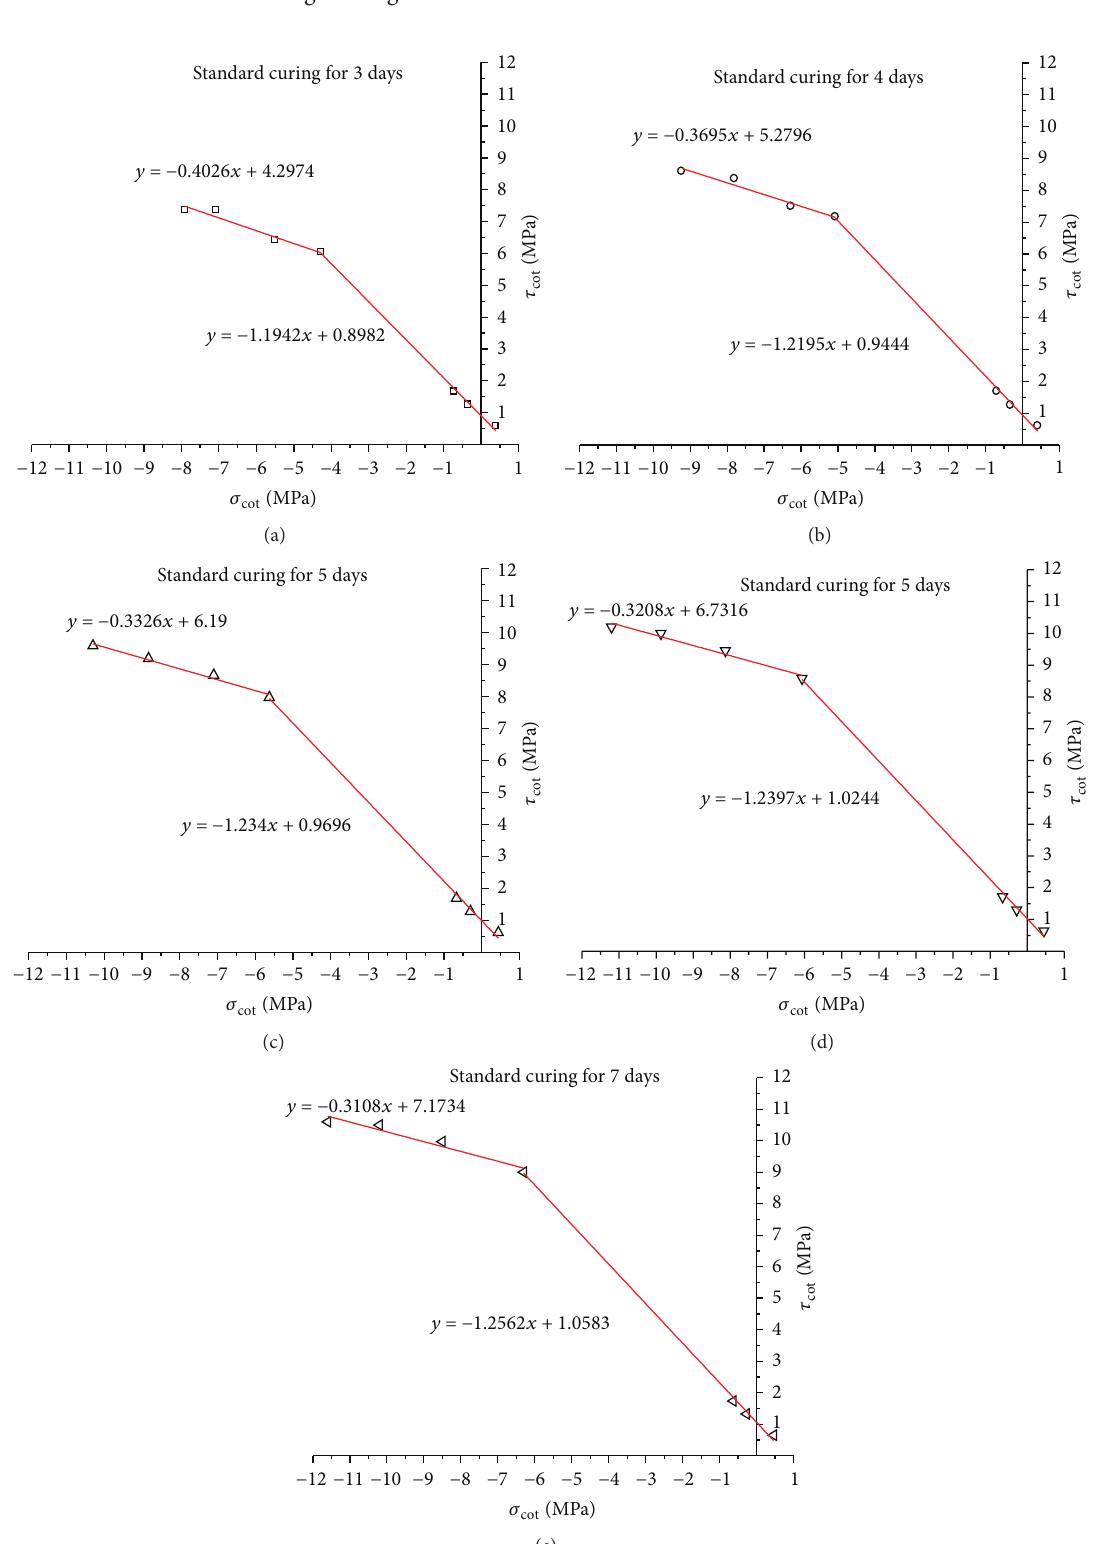
Figure 4: The results of the failure criteria for C20 concrete of various ages during the standard process of